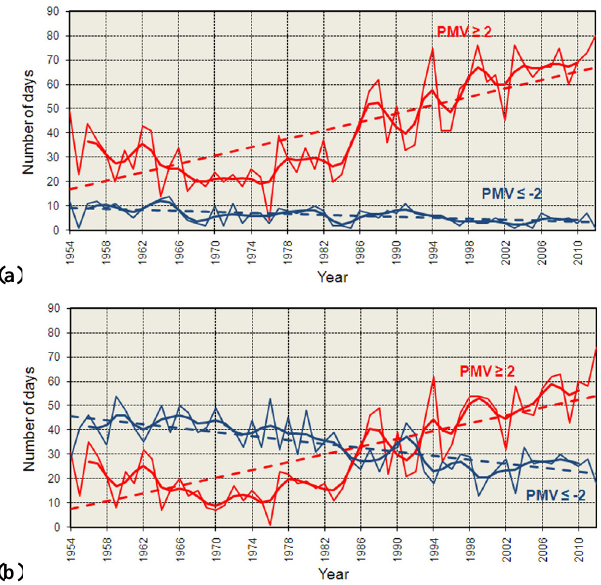
Fig. 2. Inter-annual variation of the number of summer (1 May– 30 September) days of discomfort (PMV ≥ 2 and PMV ≤ − 2) for Athens at 14:00 for the period 1954–2012 (a) for calm and (b) for light wind conditions (smoothing and trends as in Fig.